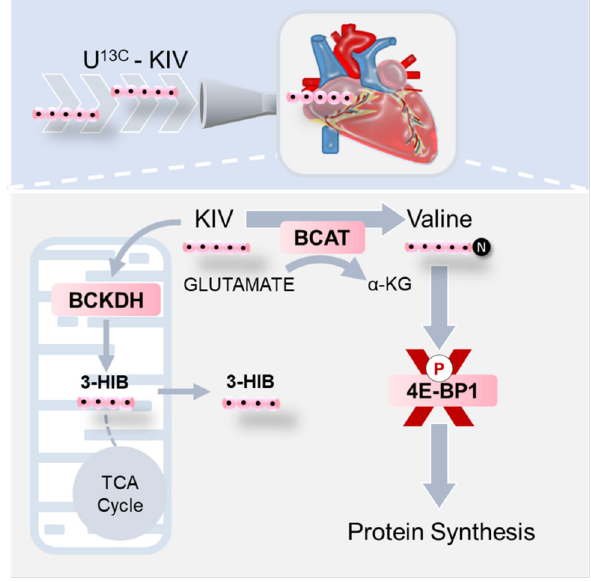
Fig. 6 Schematic of KIV fate in the heart. Stable isotope-resolved metabolomics in isolated hearts perfused with [U- 13 C] KIV demonstrates that the major fates of KIV are not oxidation to TCA cycle intermediates but rather reamination to valine and conversion to 3-hydroxyisobutyrate (3- HIB). Acute exposure of isolated hearts to increased supply of BCKA is suf fi cient to promote inhibitory phosphorylation of the translational repressor 4E-BP1 and increase protein